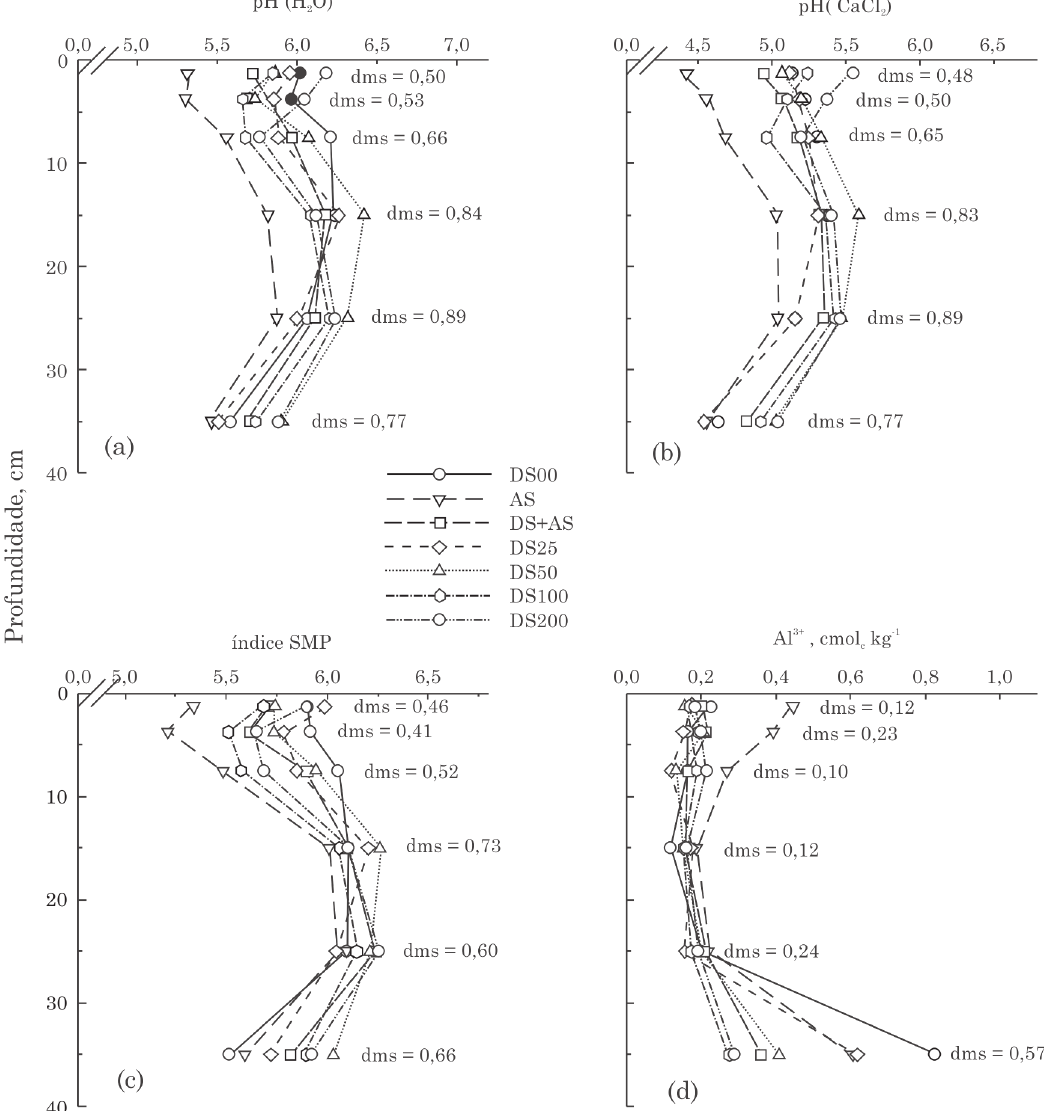
Figura 1. Valores de pH em água (a) e CaCl 2 (b), índice SMP (c) e teor de Al trocável (d) do solo nas camadas de 0-2,5, 2,5-5, 5-10, 10-20 e 30-40 cm de um Latossolo Vermelho distroférrico cultivado com a sucessão aveia-milho em sistema plantio direto e adubado anualmente com dejeto suíno nas doses de 0 (DS00), 25 (DS25), 50 (DS50), 100 (DS100) e 200 (DS200) m 3 ha -1 , adubo solúvel (AS) e dejeto suíno complementado com adubo solúvel (AS + DS). Aplicação inicial em outubro de 2001 e amostragem do solo em julho de 2010. O dms indica a diferença mínima significativa entre médias de tratamentos nas camadas pelo teste de Tukey a 5